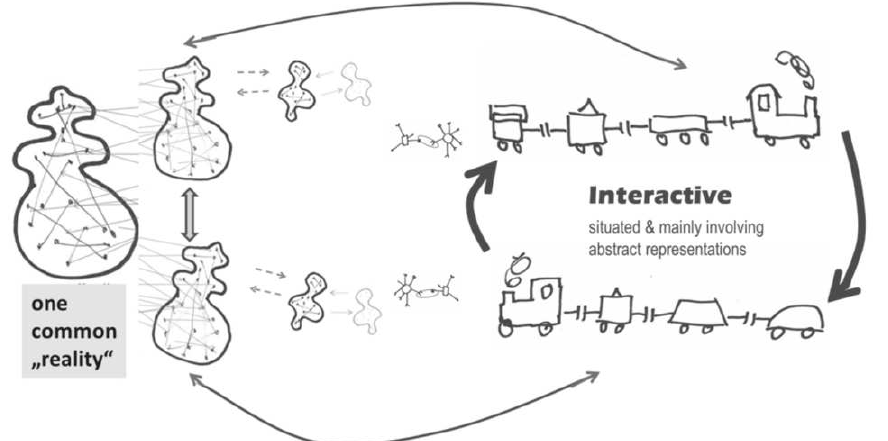
Figure 4. Overview sketch of the grounding of any conversation and the linear coding of meaning in discourse in front of a static world, see text for